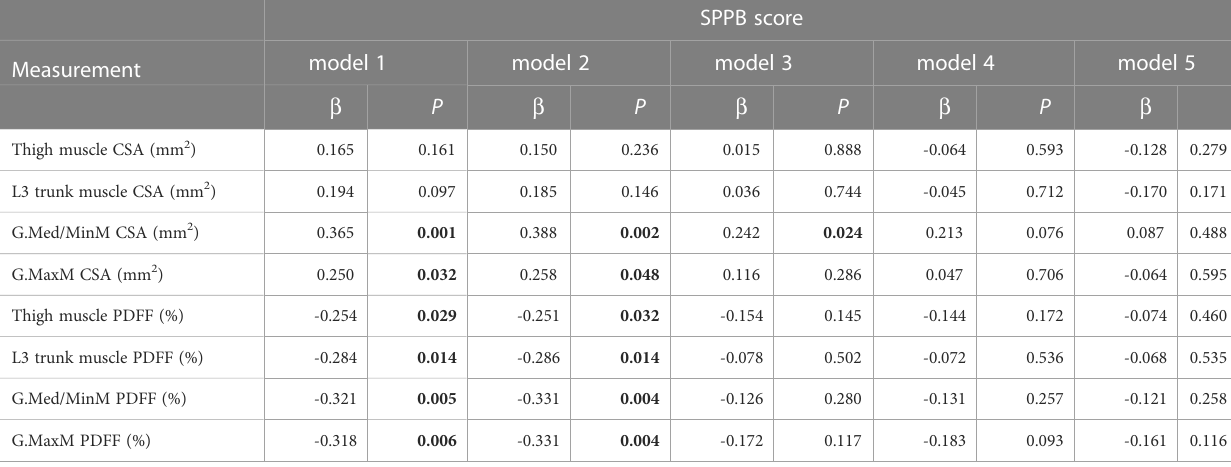
TABLE 3 Independency of muscle measurements and SPPB